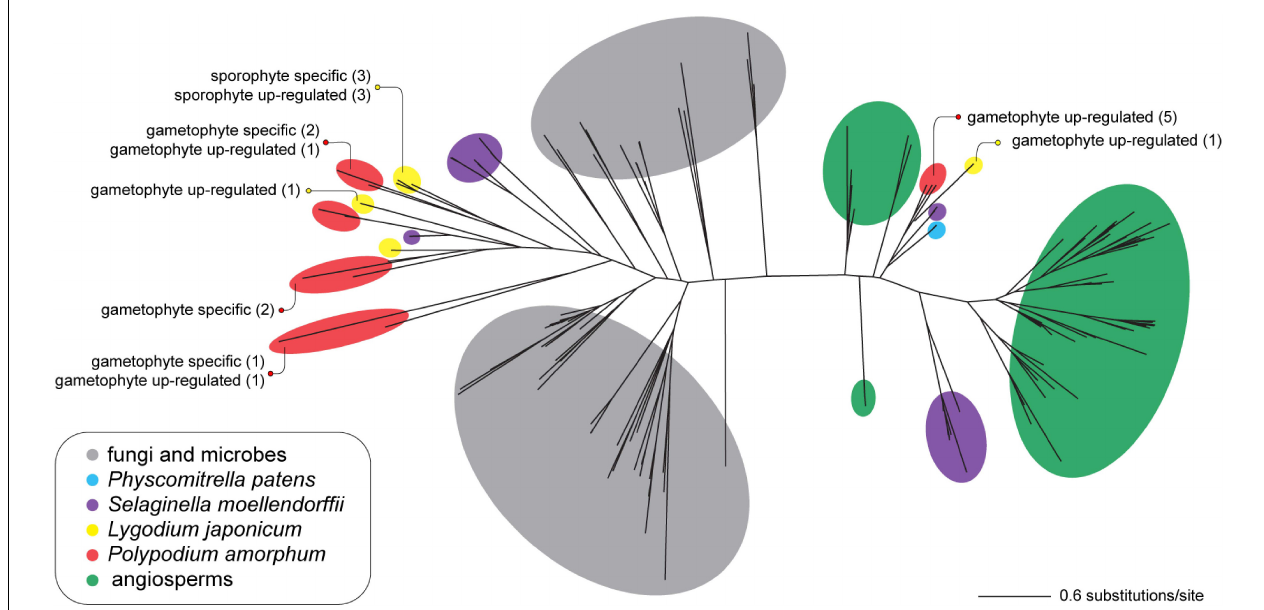
FIGURE 7 | Unrooted phylogram of the best maximum likelihood tree of terpene synthase sequences. Colored circles indicate the taxonomic identity of particular sequences (see inset legend). Text describes the number of transcripts that are phase specific or up-regulated in the ferns Polypodium amorphum (red) and Lygodium japonicum (yellow). Node support values are provided at Figshare (doi: 10.6084/m9.figshare.c.4229141).